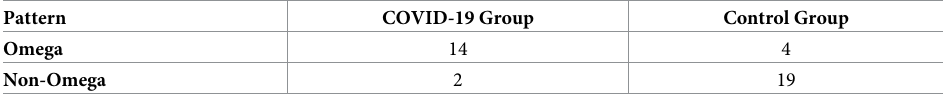
Table 2. Omega pattern clinical performance study day 1.